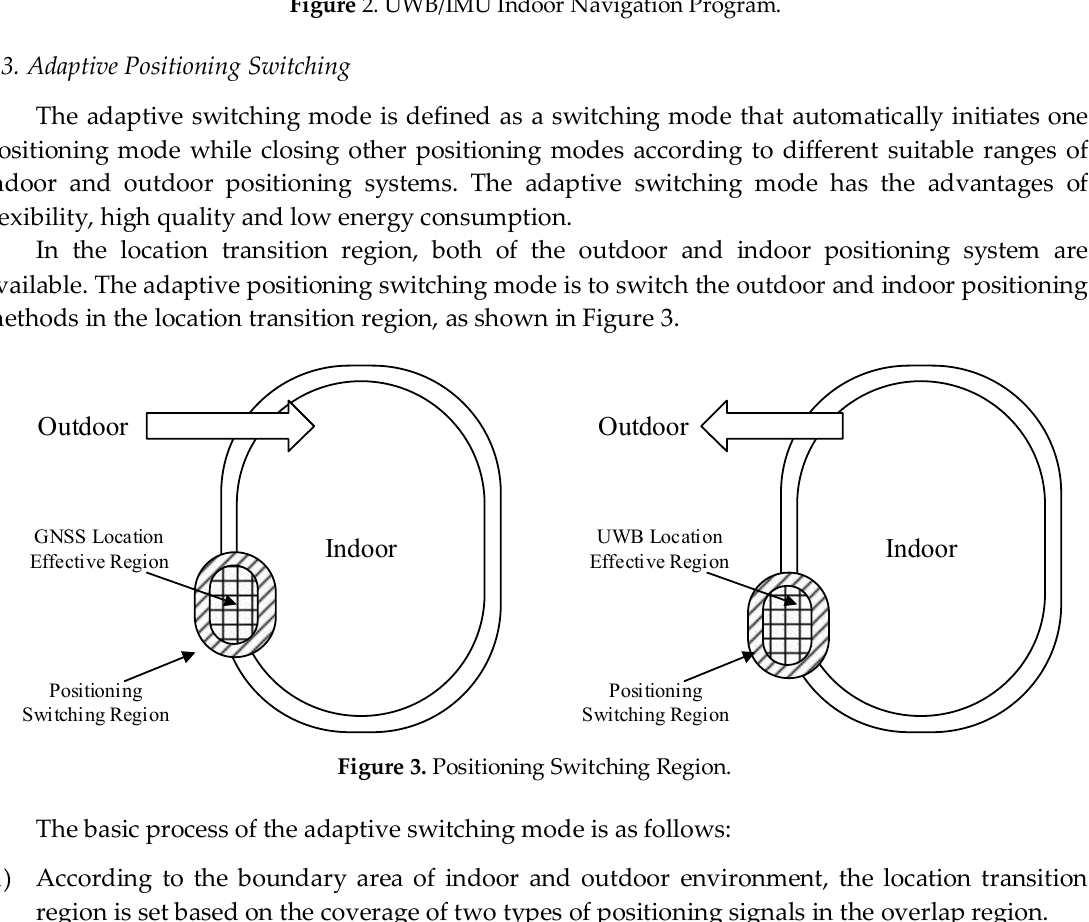
Figure 2. UWB/IMU Indoor Navigation Program.